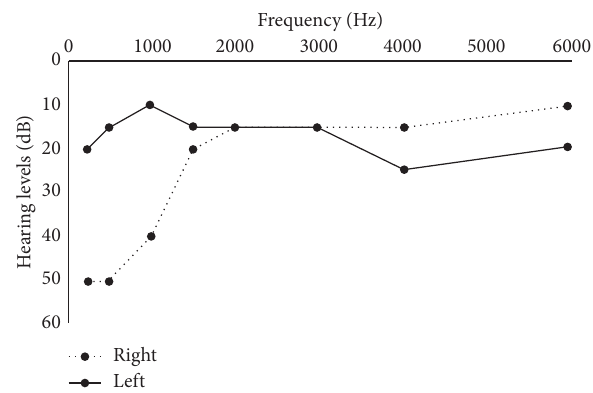
Figure 2: Audiogram results demonstrating low-frequency sen- sorineural hearing loss in the right ear (dotted line) with her left ear (solid line)